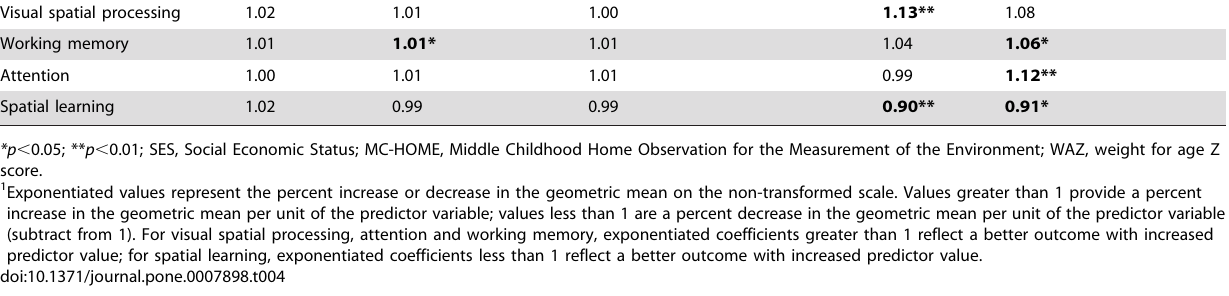
Predictor variables’